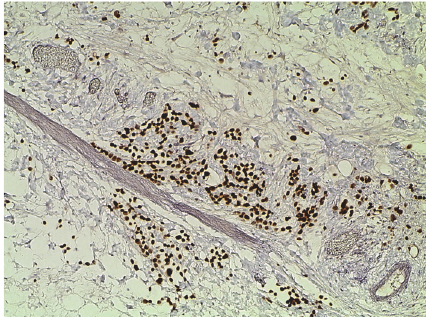
Figure 2: Strong and diffuse nuclear immunoreactivity for GATA3 by tumor cells in the transurethral bladder resection specimen ( ×